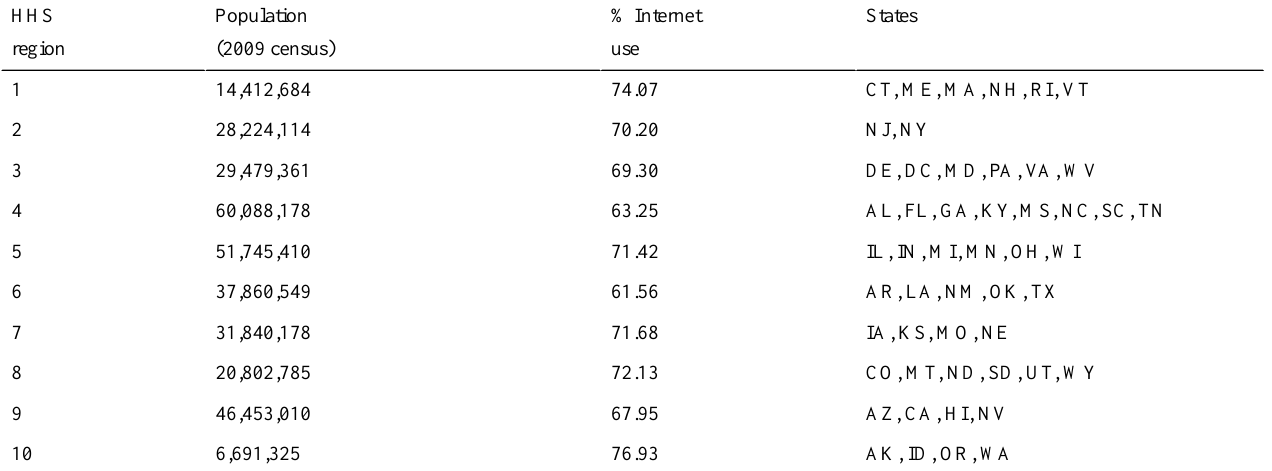
Table 1. Population and percentage Internet use by US Department of Health and Human Services (HHS) region.